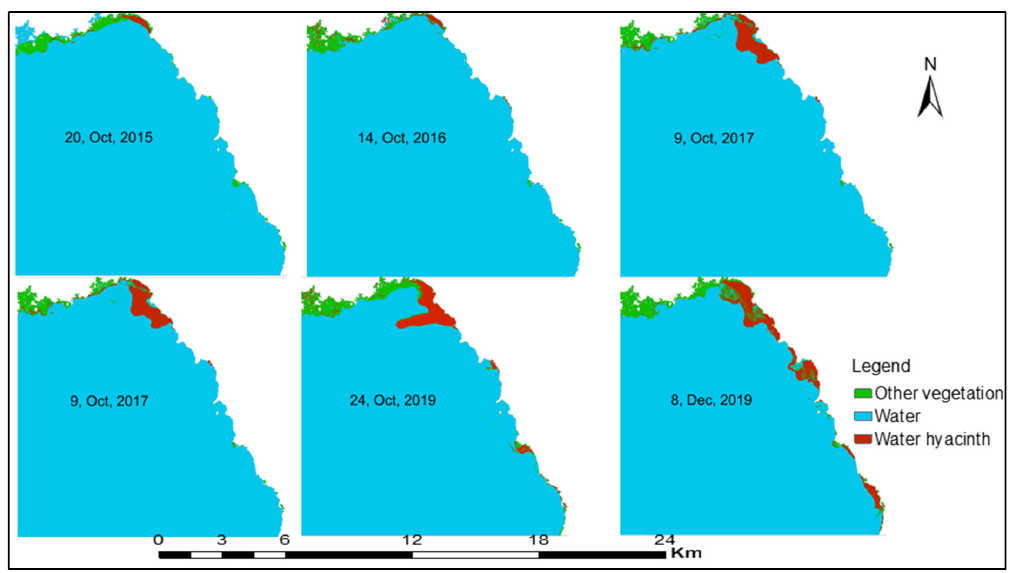
Figure 4. Spatial and temporal map of annual maximum area covered by water hyacinth in the north, northeast and eastern shore of the Lake Tana from northeast and eastern shore of the Lake Tana from 2015–2019.